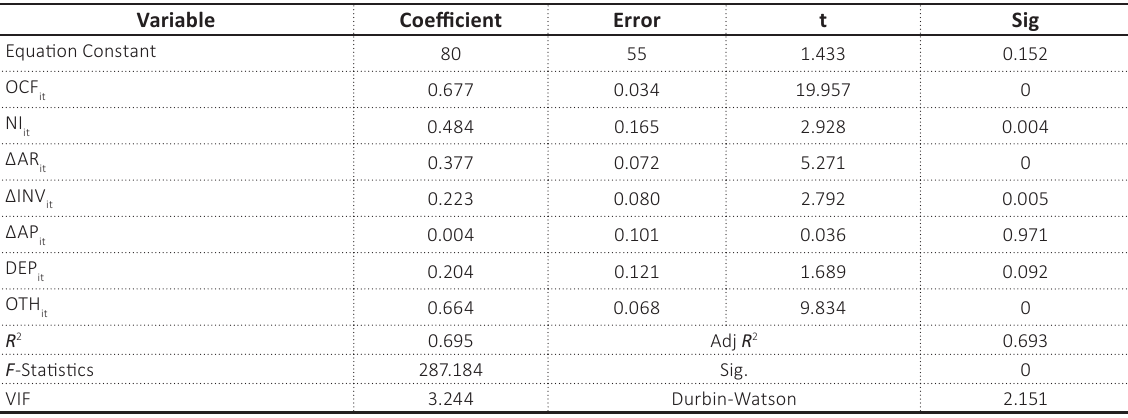
Table 3. Hypothesis 1